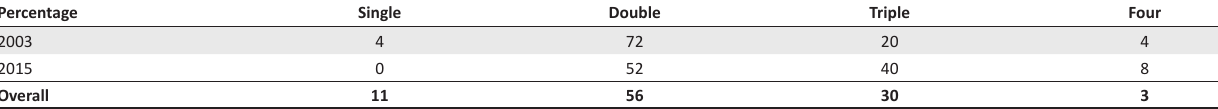
TABLE 2: Multiple authorship in South African Journal of Human Resource Management: 2003–2015.